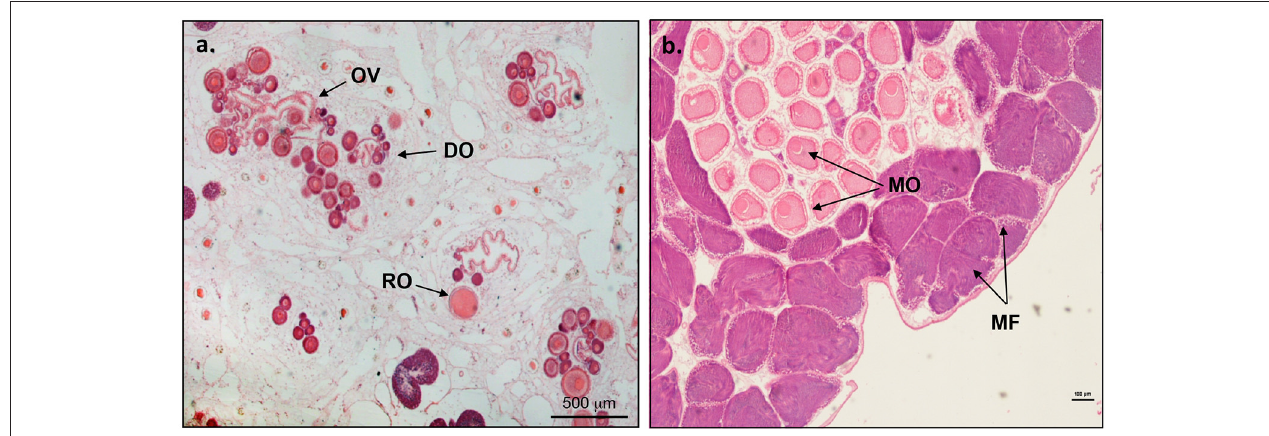
FIGURE 2 | Microcosmus exasperatus . Close-up of gonad histology cross-sections taken under light microscope and stained with hematoxylin and eosin. (A) Developing oocytes (DO) grouped around the ciliated oviduct (OV) and residual oocytes (RO) from the previous reproductive cycle. Scale bar = 500 µ m, and (B) Mature gonad close- up. The male follicles (MF) are situated in the periphery of the gonad, surrounding the oocytes (MO- mature oocytes). Scale bar = 100 µ